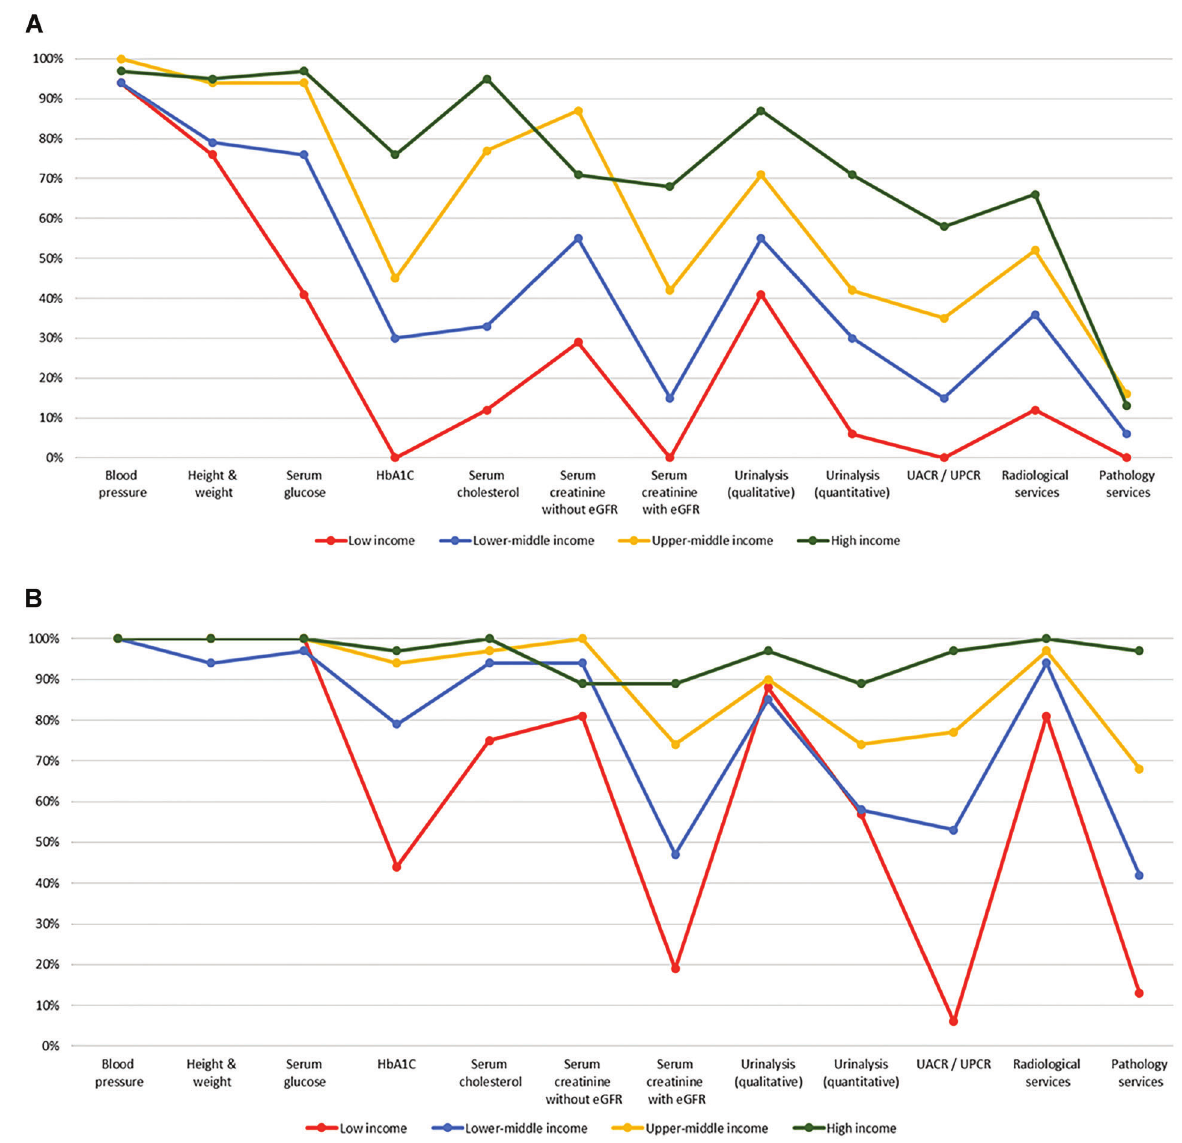
Figure 1. Health care services for identi fi cation and management of chronic kidney disease by country income level. ( A ) Primary care (i.e., basic health facilities at community levels [e.g., clinics, dispensaries, and small local hospitals]). ( B ) Secondary/specialty care (i.e., health facilities at a level higher than primary care [e.g., clinics, hospitals, and academic centers]). eGFR: estimated glomerular fi ltration rate; HbA1C: glycated hemoglobin; UACR: urine albumin-to-creatinine ratio; UPCR: urine protein-to-creatinine ratio. Data from Bello et al. (4) and Htay et al.